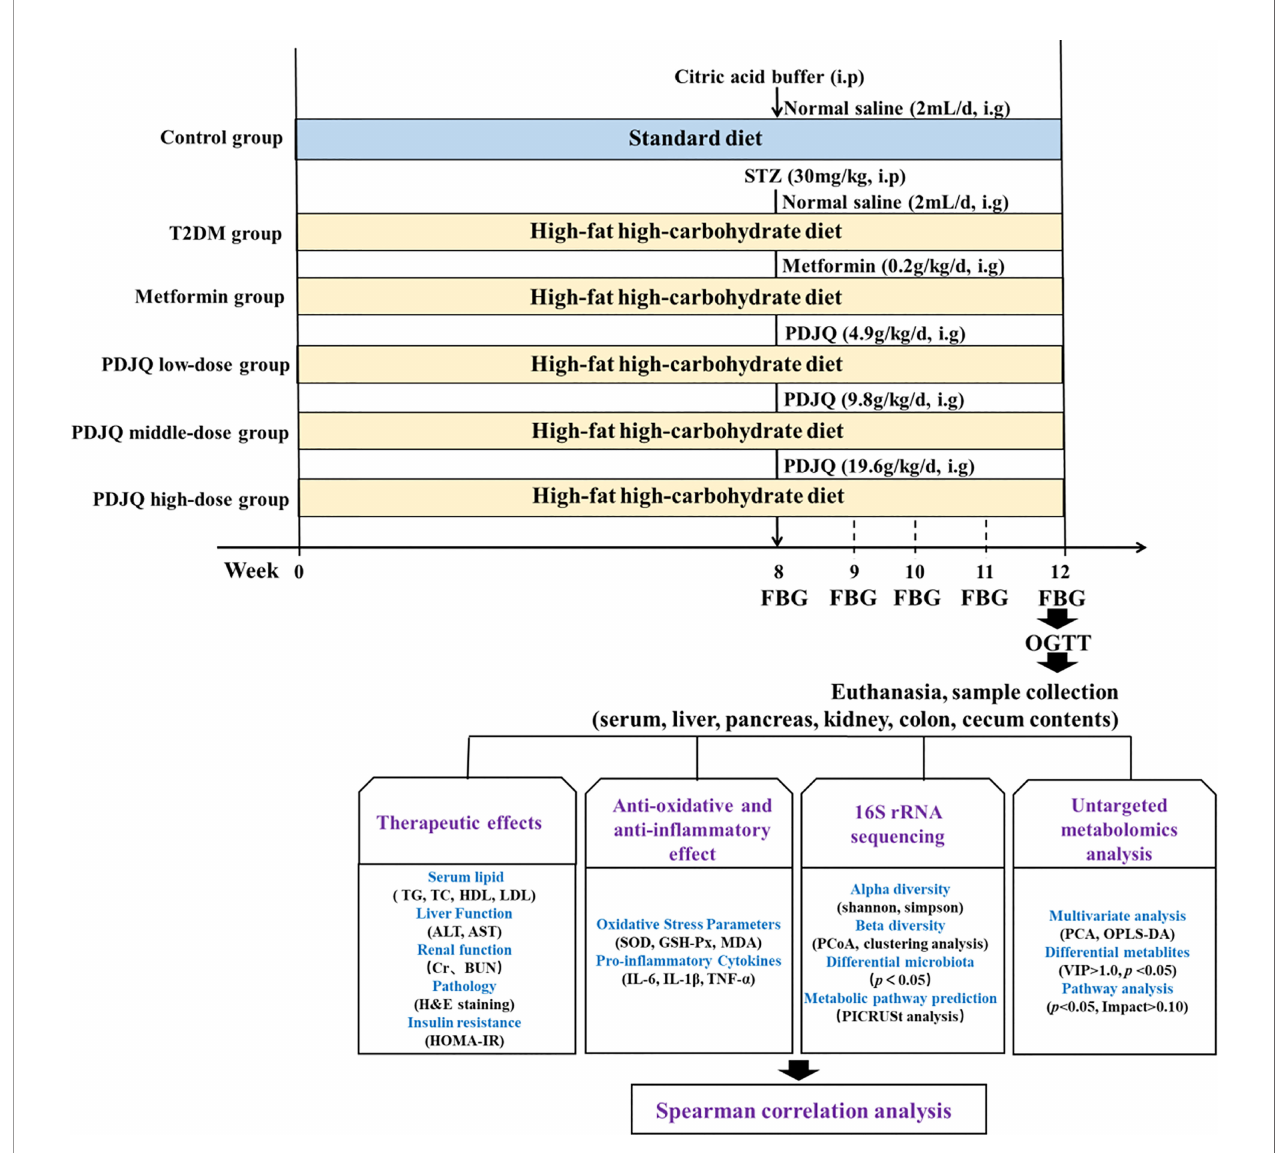
FIGURE 1 | Overview of the experimental design for all